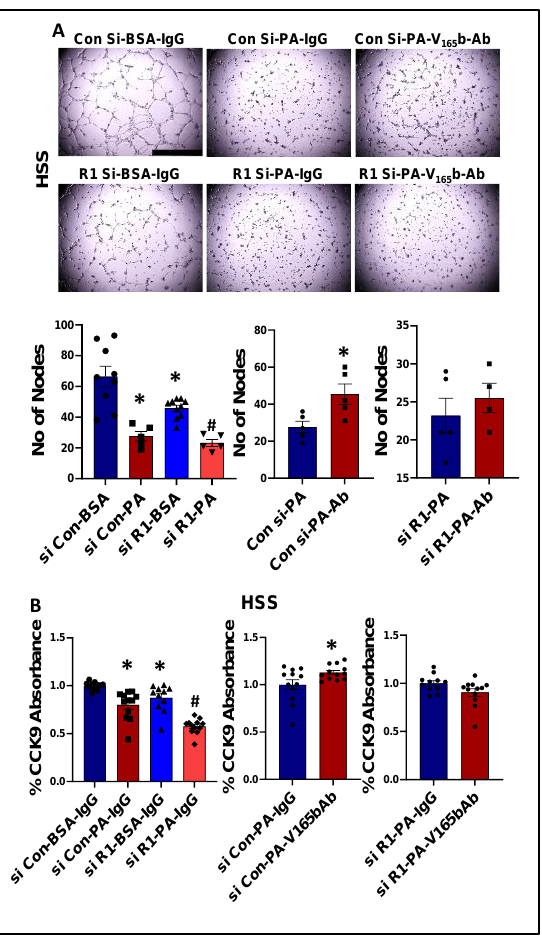
Figure 8. VEGF 165 b inhibition restores impaired angiogenic capacity and improves endothelial survival that is dependent on VEGFR1 in in vitro diabetic-PAD model: ( A ) In vitro tube formation assay of HUVECs transfected with non-targeting control siRNA (Con Si) or VEGFR1 siRNA (R1 Si), treated with BSA or BSA-Palmitic acid (500 µ M) and IgG or V 165 b-Ab (10 µ g/mL) for 24 h under HSS conditions, n ≥ 4. One-way ANOVA with Bonferroni select pair comparison. * indicates significantly different from Con Si-BSA-IgG, # indicates significantly different from R1 Si-PA-IgG. Unpaired t -test for IgG vs. V 165 b-Ab comparisons. Scale-100 um. ( B ) Cell proliferation/survival assay of HUVECs transfected with non-targeting control siRNA (Con Si) or VEGFR1 siRNA (R1 Si), treated with BSA or BSA-Palmitic acid and IgG or V 165 b-Ab for 24 h under HSS conditions, n ≥ 11. One-way ANOVA with Bonferroni select pair comparison * indicates significantly different from Con Si-BSA-IgG, # indicates significantly different from Con Si-PA-IgG and R1 Si-PA-IgG. Unpaired t -test for IgG vs. V 165 b-Ab comparisons. * p < 0.05 considered significant. Data Mean ± SEM.